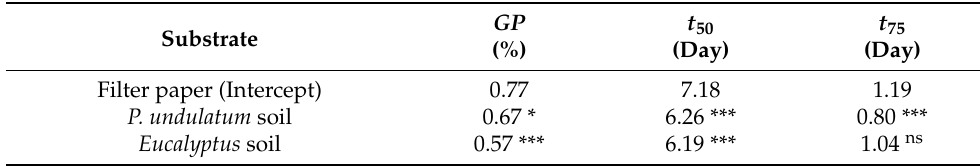
Table 1. Germination of Eucalyptus ovata seeds under different substrates (i.e., filter paper; P. undu- latum soil; Eucalyptus soil). In the GP , t 50 and t 75 columns are reported the values obtained from the Nonlinear Mixed-Effects Model ‘( GP + t 50 + t 75 ~ substrate)’ with the function SSLogis() and in superscript are noted the significance levels obtained from nlme() (ns > 0.05, * 0.01 < p < 0.05, *** p < 0.001) (the relative summary are reported in Table